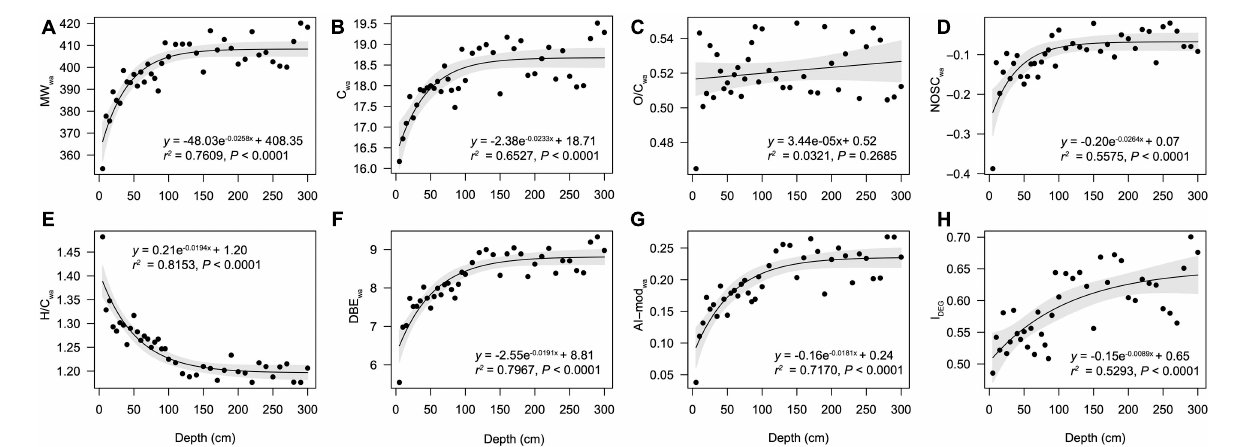
FIGURE 1 | Patterns of molecular parameters of DOM along depth. Intensity weighted average values are displayed for (A) molecular weight (MW wa ), (B) number of carbon (C wa ), (C) O/C ratios (O/C wa ), (D) nominal oxidation state of carbon (NOSC wa ), (E) H/C ratios (H/C wa ), (F) double bond equivalent (DBE wa ), and (G) modified aromaticity index (AI-mod